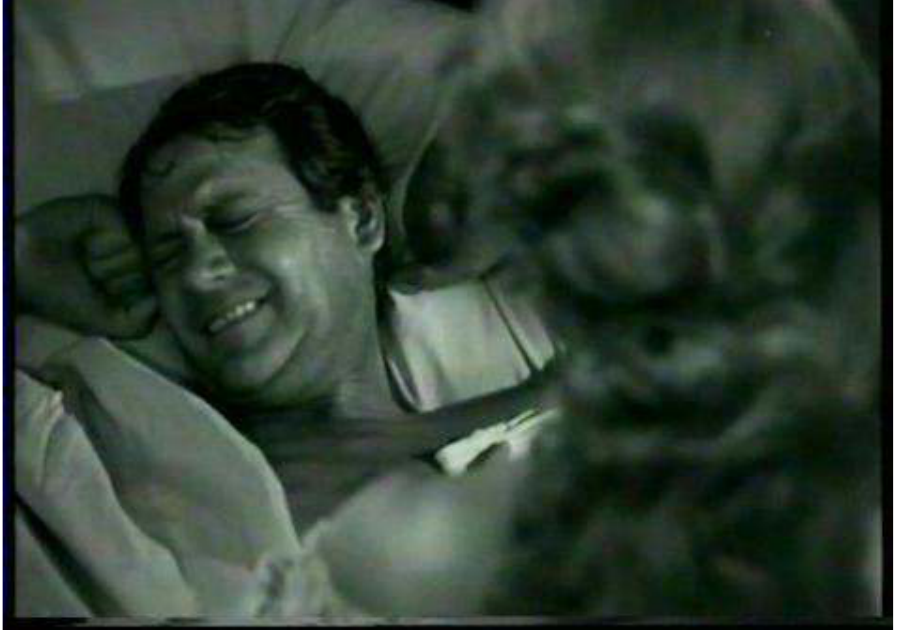
Figure 15: Colorado penetrating the male body in Colorado Territory